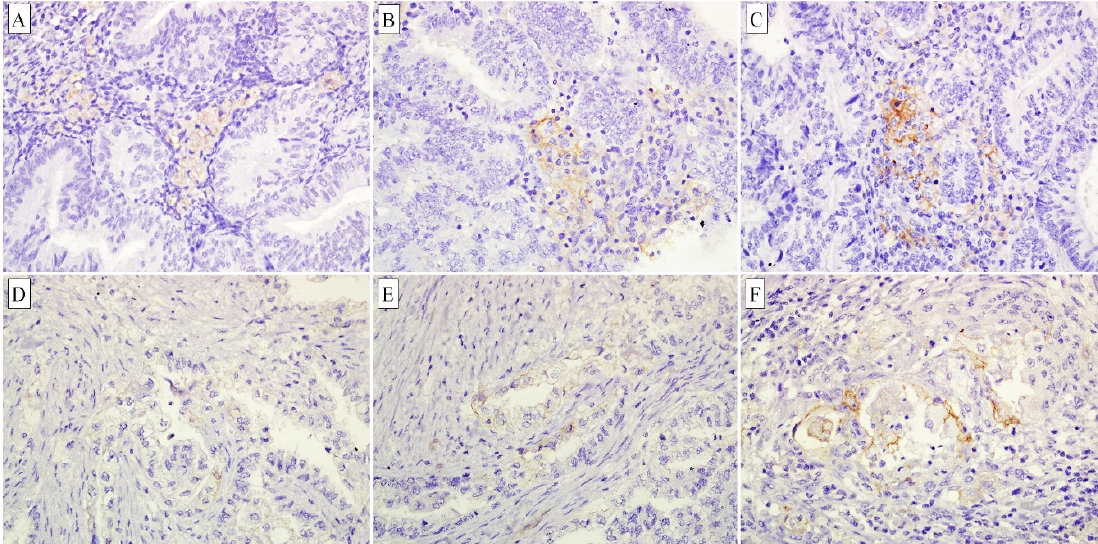
Figure 2. PD-L1 immunohistochemistry showed membranous staining in immune cells and tumour cells. ( A – C ) Weak, moderate and strong PD-L1 staining in immune cells (400 × ); ( D – F ) Weak, moderate and strong PD-L1 staining in tumour cells (400×). Table 2. Expression of PD-L1 in immune cells and tumour cells.